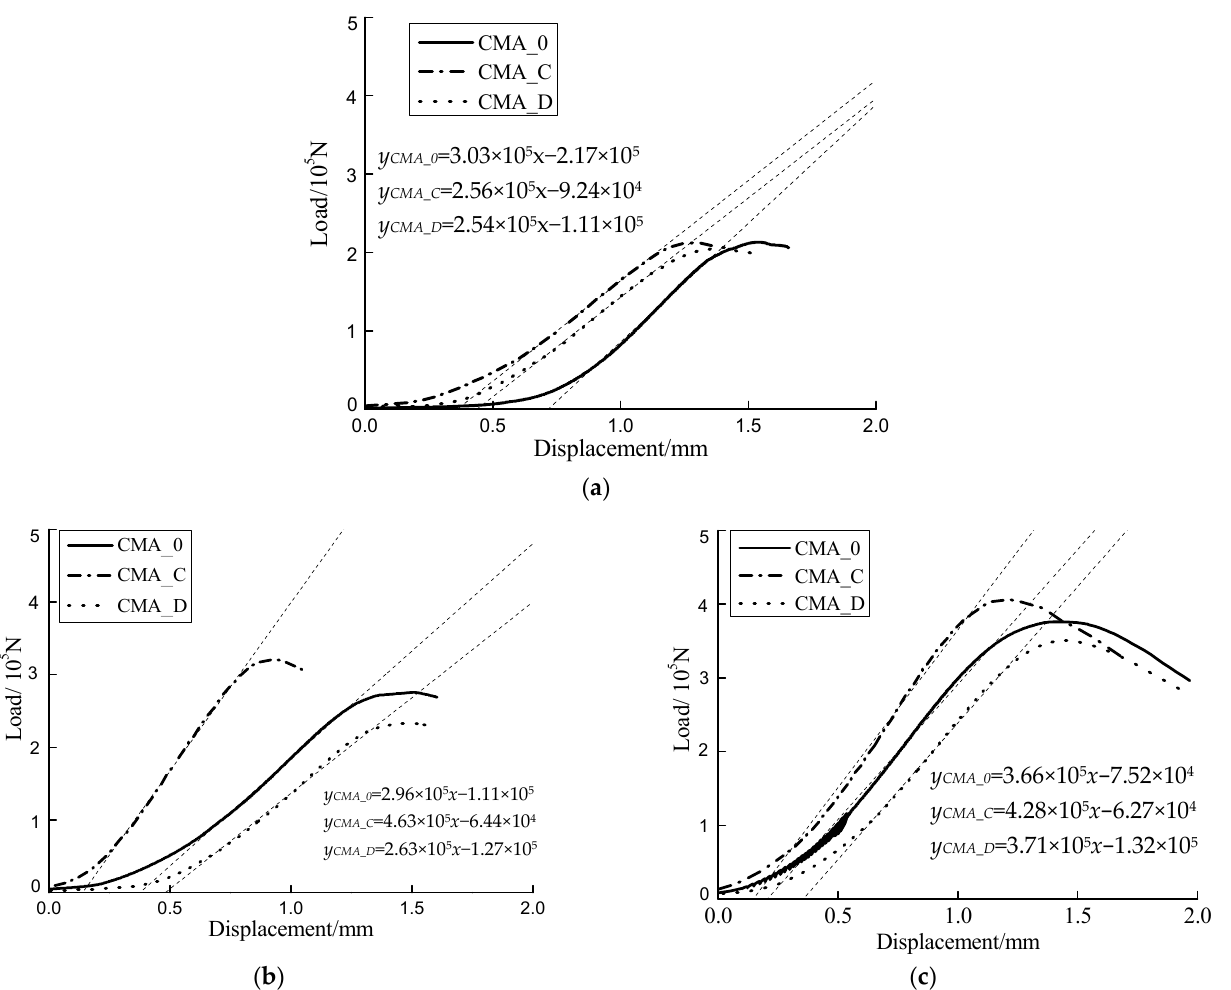
Figure 5. Load-displacement curve: ( a ) 3d; ( b ) 7d; ( c ) 28d.